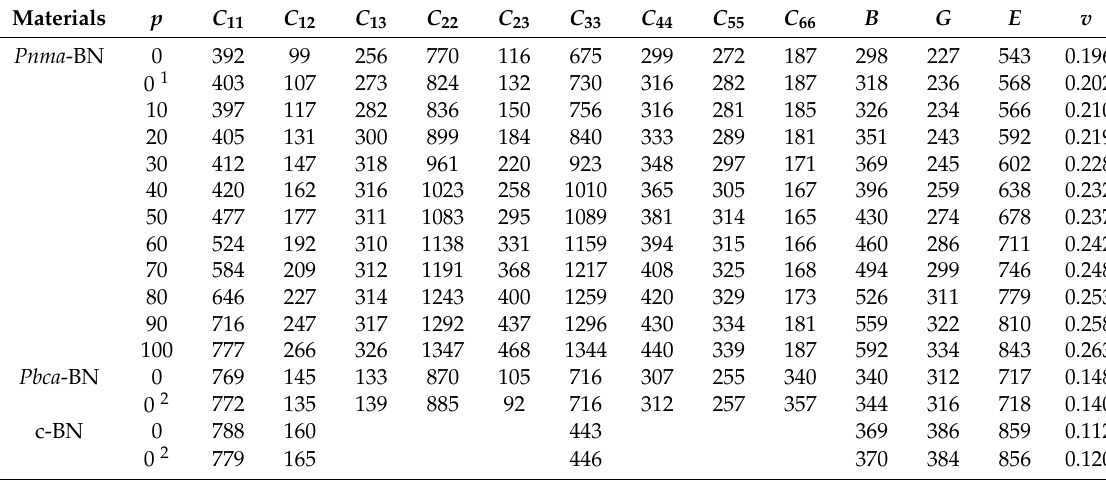
Figure 3. The phonon spectra of Pnma -BN at 0 GPa ( a ) and 100 GPa ( b ); Mixing enthalpy Δ H of BN alltropes calculated using PBE ( c ).